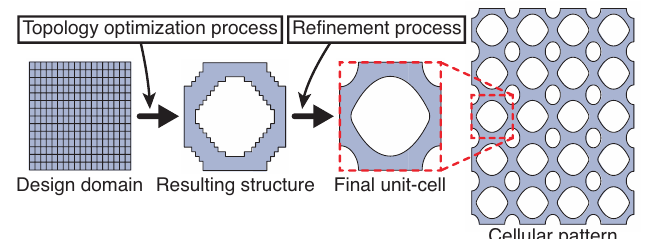
Figure 9. Process to tailor stiffness using Topology Optimization applied to the unit cells of Cellular